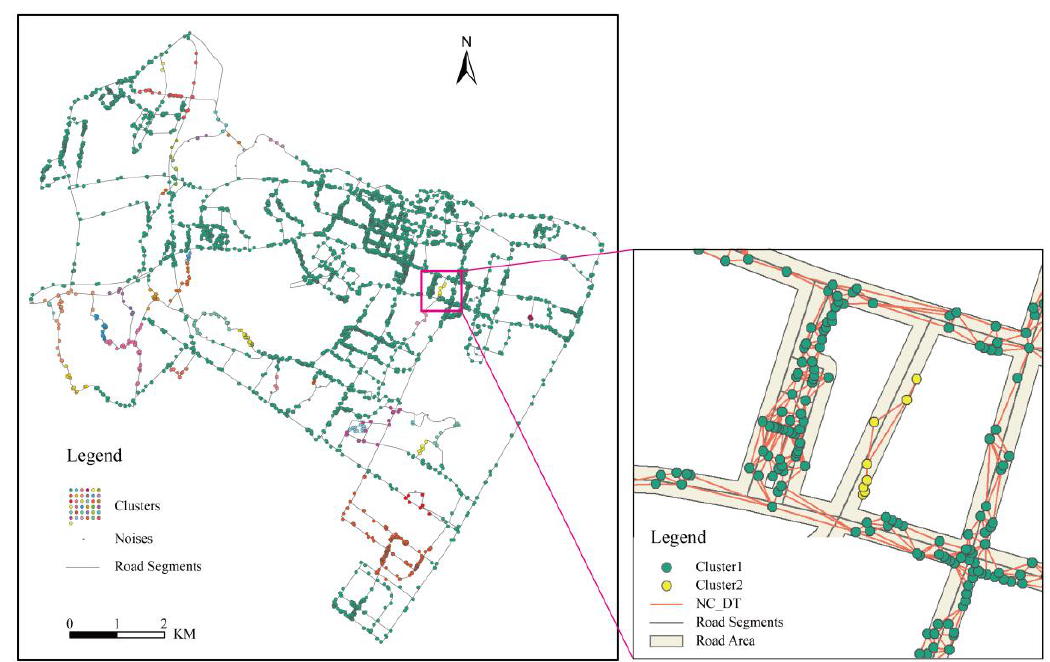
Figure 11. Clusters of NC_DT algorithm does not work e ff ectively for the dataset. Table 4. Indicators for Evaluating the E ff ectiveness of Clustering